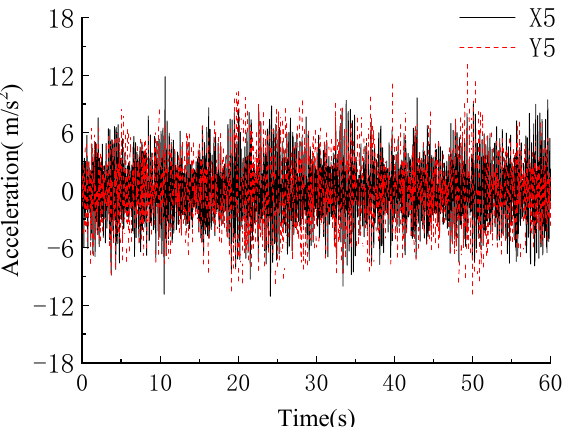
Figure 2. Noise-added acceleration time histories at Point A5.